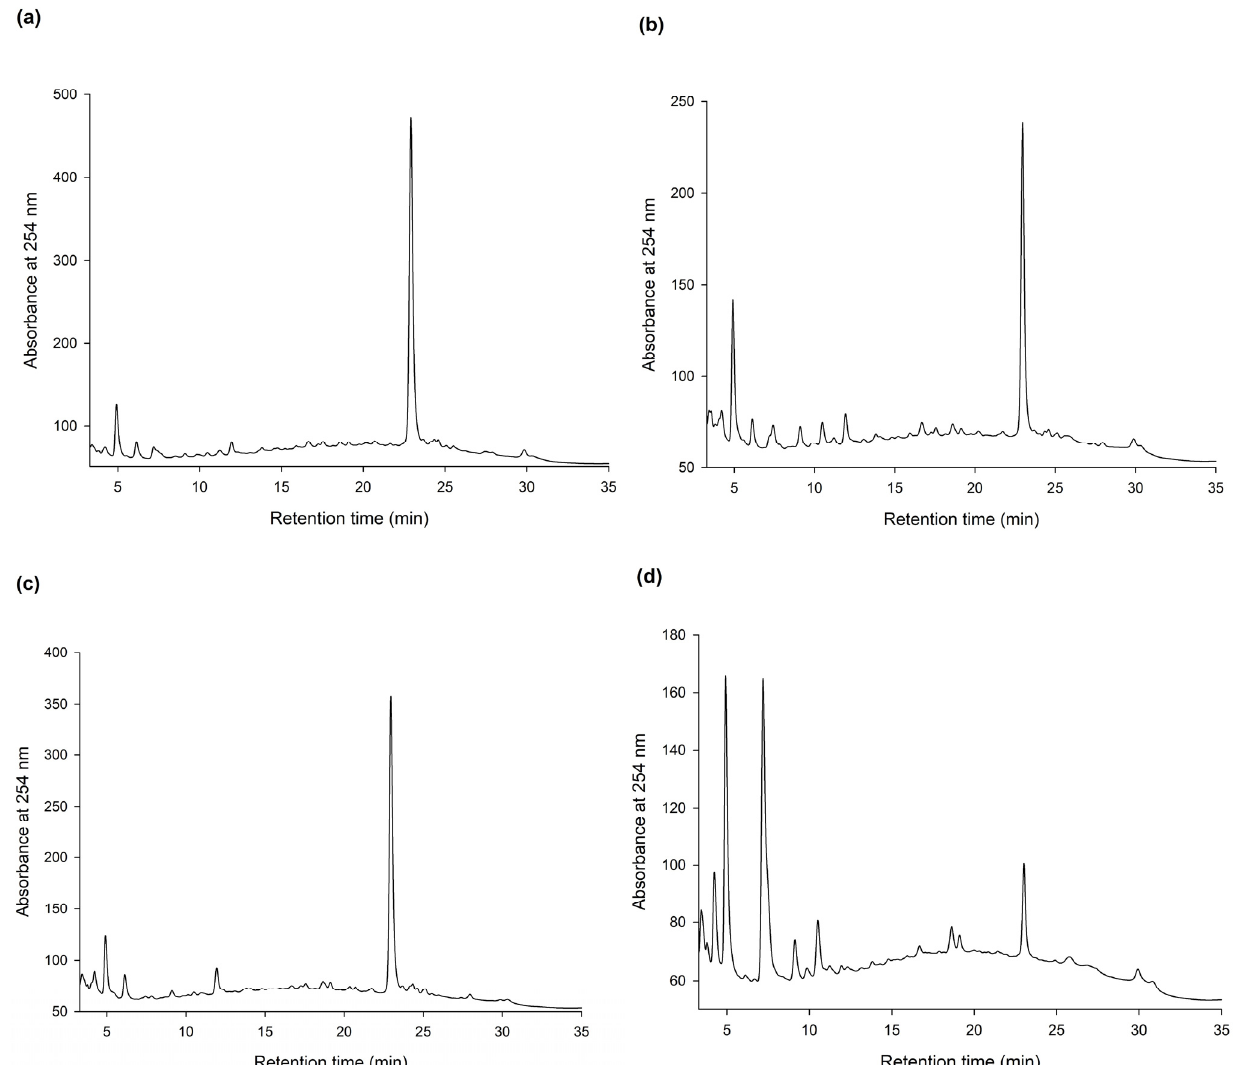
Figure 1. High-performance liquid chromatography (HPLC) analysis of the methanol extracts (5 mg/mL) from four different brands, Sun Ten ( a ), Ko Da ( b ), Chuang Song Zong ( c ), and Min Tong ( d ), of Ha-Soo-Oh herb medicine. The HPLC operation procedure is described in Section 2.4.